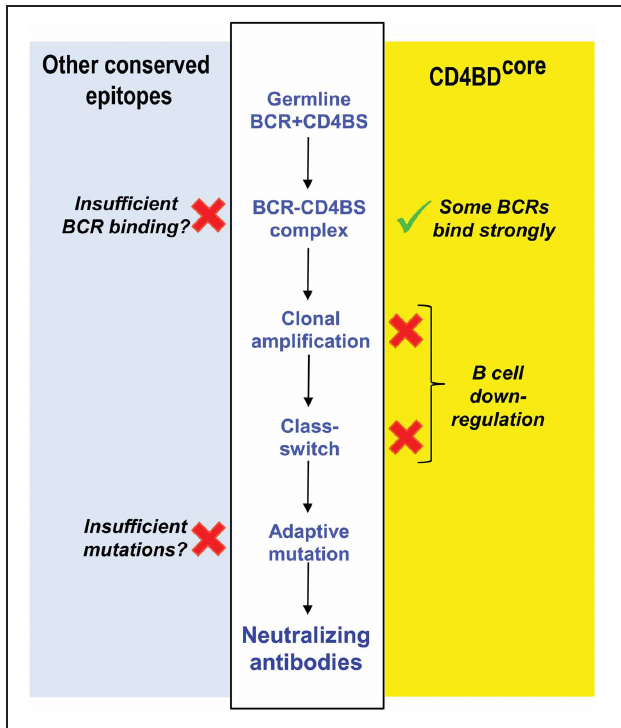
FIGURE 2 | Reasons underlying failed induction of antibodies to CD4BD. Competing hypotheses advanced to explain failure of adaptive antibody synthesis to the CD4BD. Middle white panel: regulatory check-points in B cell differentiation influencing neutralizing antibody production. Right yellow panel: the CD4BD core is a B cell superantigenic epitope that binds the FRs of constitutive BCRs non-covalently, but this causes B cell down-regulation. In contrast, covalent vaccination up-regulates B cells. Left light blue panel: other popular hypotheses based on studies by Dimitrov and coworkers, Scripps Institute investigators and NIH Vaccine Research Center investigators. Sufficient V gene mutations needed to bind CD4BD do not occur. Alternatively, the affinity of conserved HIV epitopes for BCRs is too low. NAbs, neutralizing antibodies. X, √ weakness in B cell response. , our proposed basis for HIV